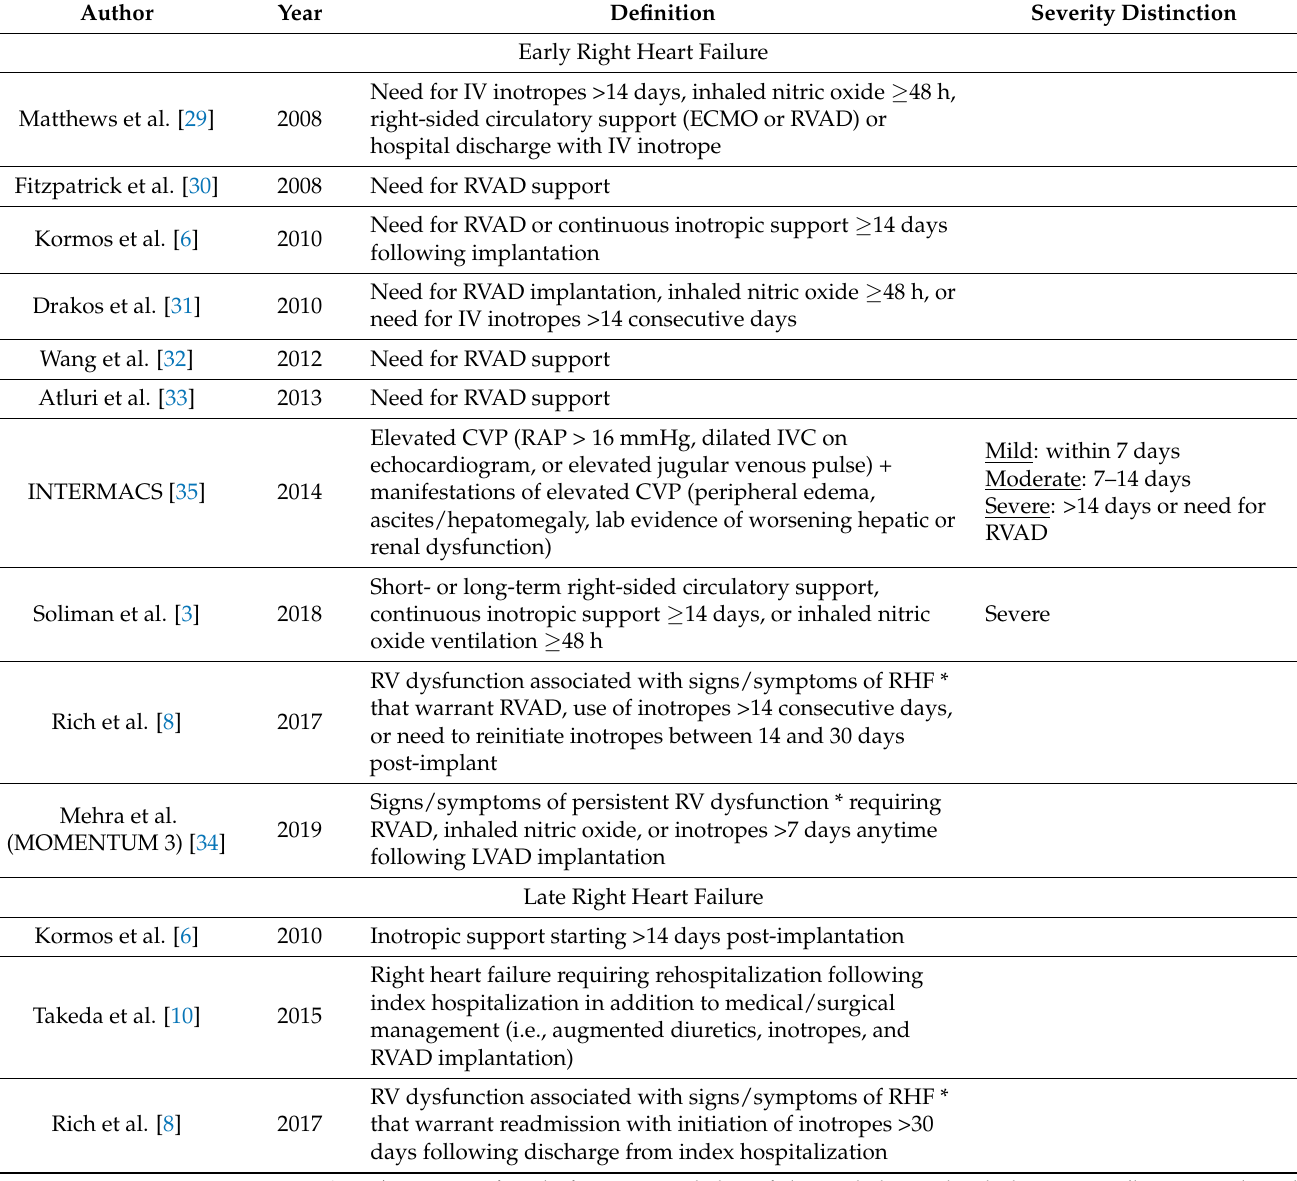
Table 1. Varying definitions of early and late right heart failure following LVAD